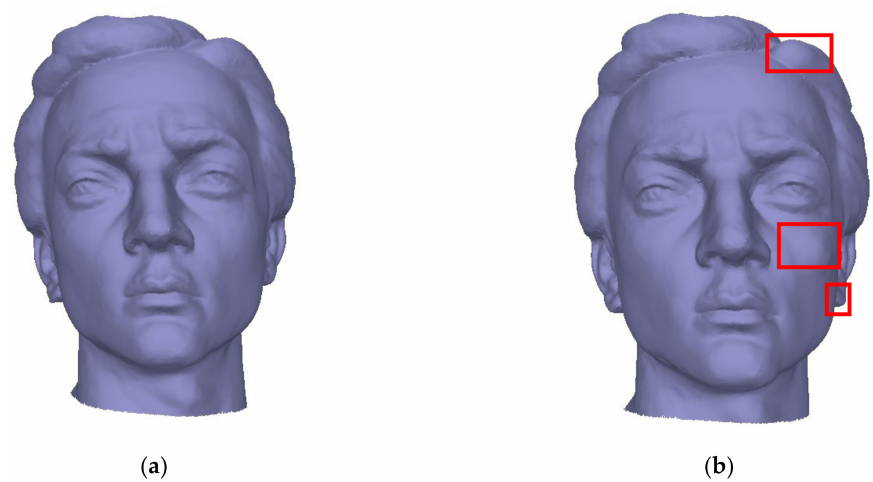
Figure 7. Obtained 3D models using 3D laser scanner: ( a ) original model; ( b ) a model with added clay details (framed by red